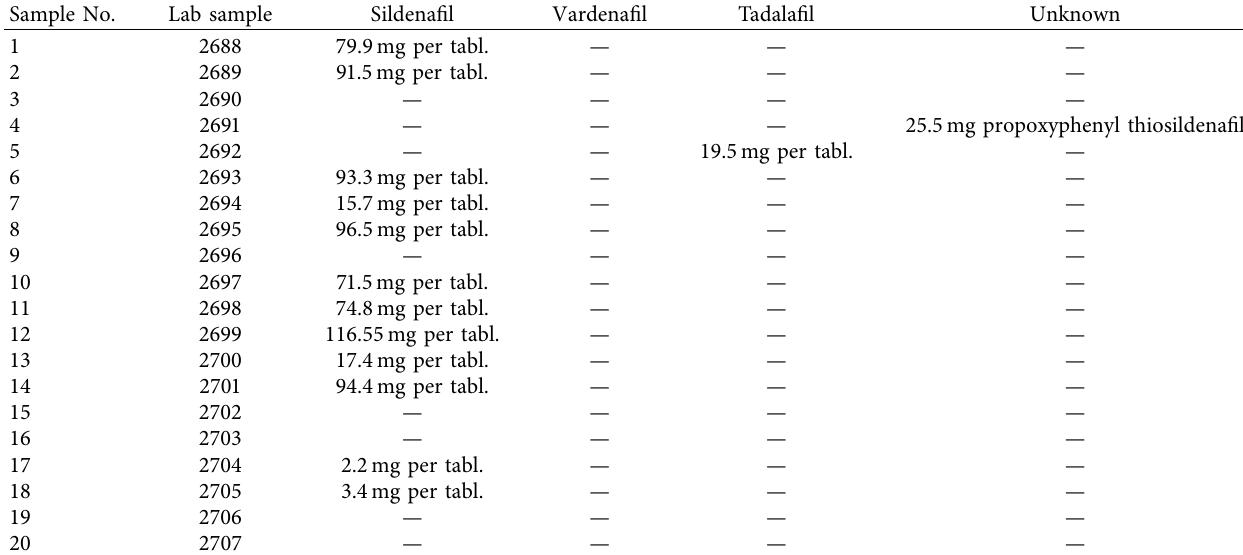
Table 1: Generalized results for determination of the presence/absence of sildenafil, tadalafil, vardenafil, unknown ingredients, and their respective amounts. Sample